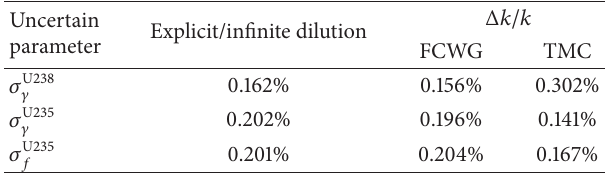
Table 3: 𝑘 ∞ uncertainty attributable to resonance group covariance of selected cross-sections.